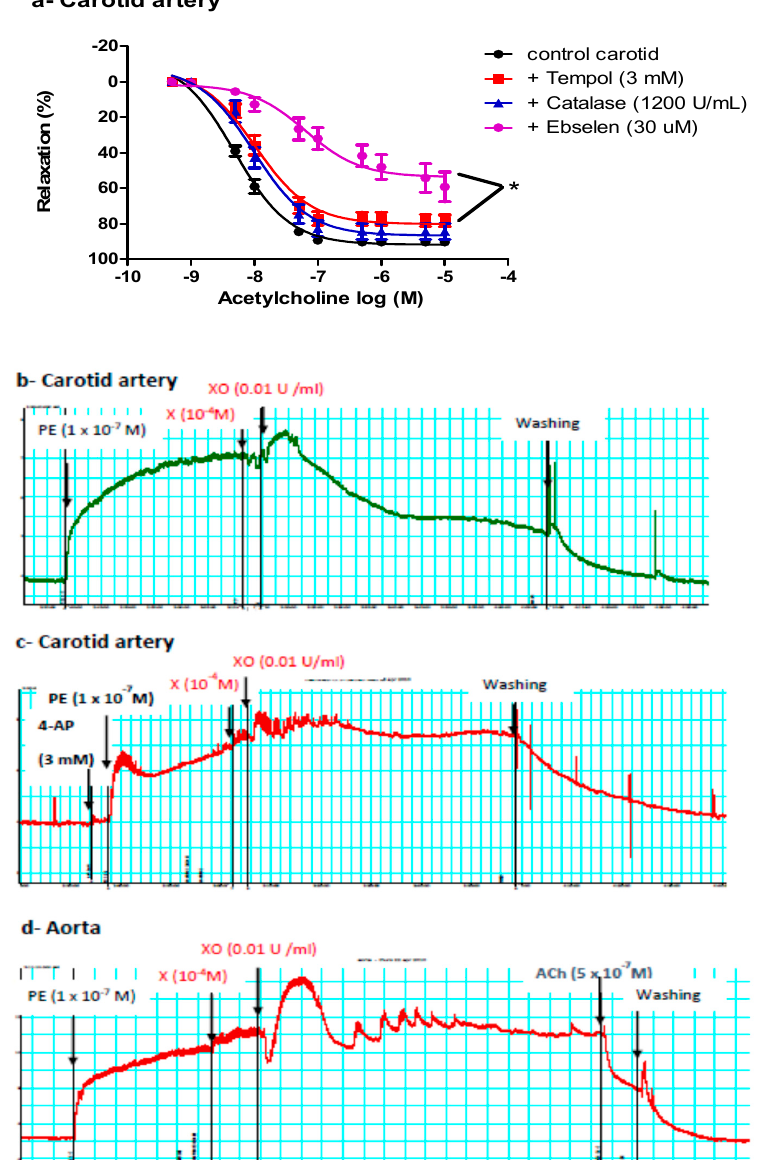
Figure 3. Role of reactive oxygen species (ROS) in mediating vasodilatation in the carotid artery. ( a ) Cumulative concentration–response curves of acetylcholine in the carotid arteries of control and db/db mice (14–20 weeks old) in the presence or absence of tempol, catalase, or ebselen ( n = 5–10 mice). ( b ) A representative trace showing vasodilatation after adding xanthine and xanthine oxidase to the carotid artery ( n = 16 rings from six mice). ( c ) A representative trace showing inhibition of the vasorelaxant effect of xanthine and xanthine oxidase in the carotid artery in the presence of 4-aminopyridine ( n = 4 from four mice). ( d ) A representative trace showing no vasodilatation after adding xanthine and xanthine oxidase to the aorta ( n = 9 rings from five mice). For traces in panels b, c and d: x-axis is time (minutes) and y-axis is force (mN). 4-AP = 4-aminopyridine, Ach = acetylcholine, PE = phenylephrine, X = xanthine, XO = xanthine oxidase.